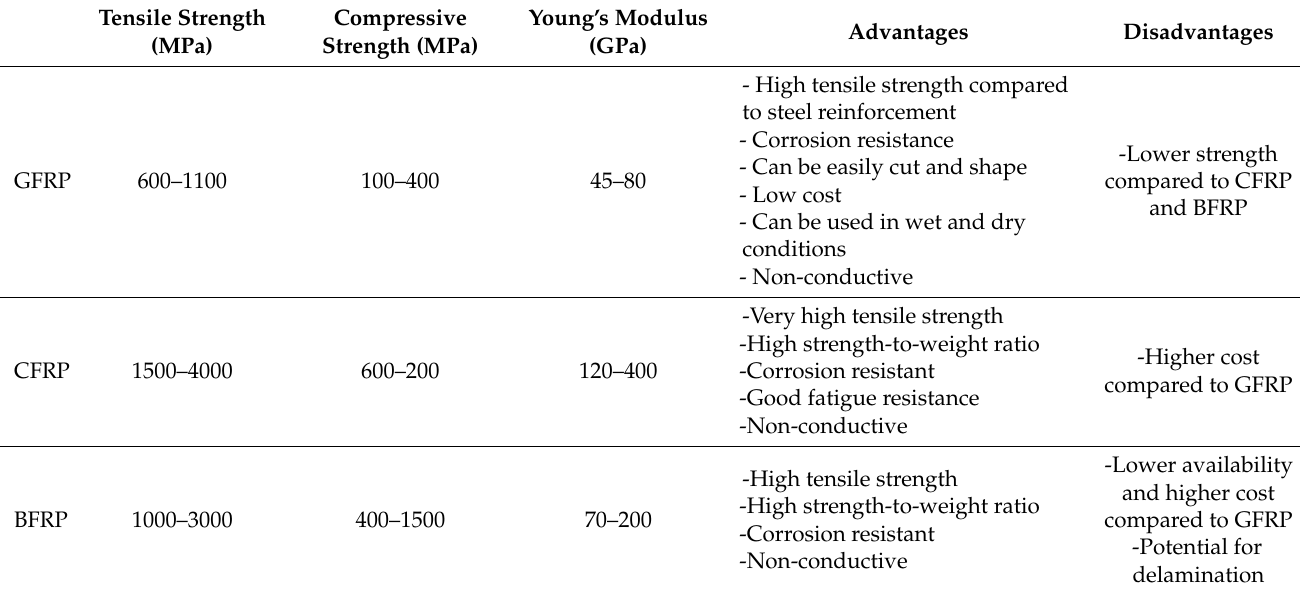
Table 1. Overview of FRP variants.